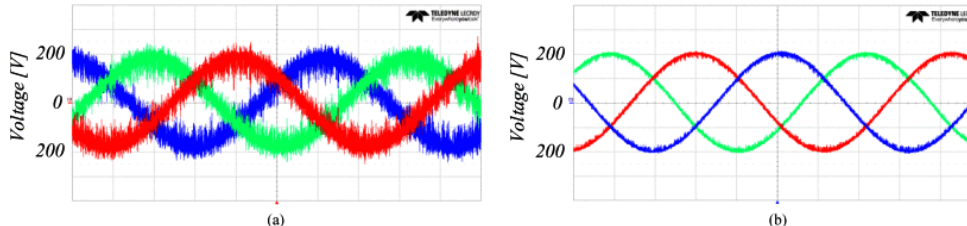
Figure 28. Comparison of different controllers for a change of 30% in capacitance. ( a ) MPC perfor- mance. ( b ) MFPC performance.